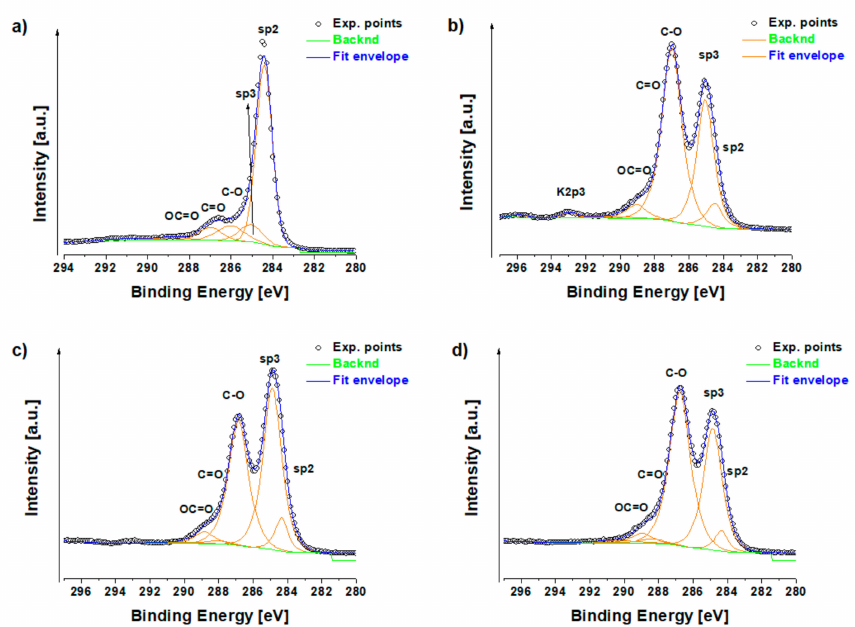
Figure 1. X-ray photoelectron spectroscopy C1s region spectra of ( a ) graphite powder; ( b ) graphene oxide; ( c ) graphene oxide platforms with magnetic nanoparticles modified antibodies (GO-MNps-MAb) and ( d ) graphene oxide platforms with magnetic nanoparticles modified antibodies in the presence